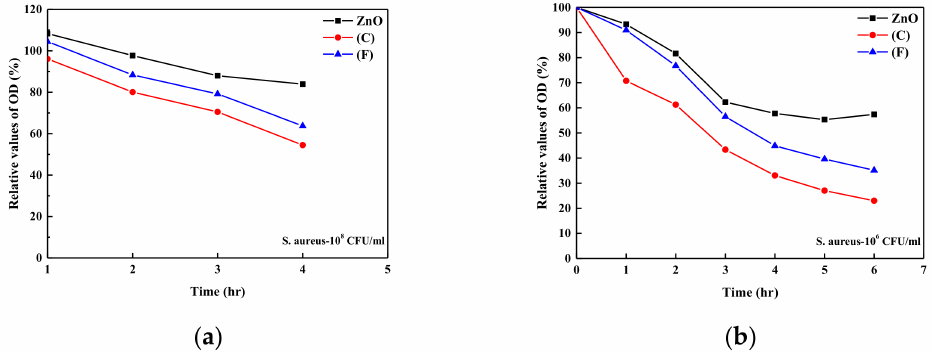
Figure 7. Relative optical density values as a function of time for ( a ) the initial S. aureus concentration of 10 8 CFU / mL and ( b ) 10 6 CFU / mL with pure ZnO sample; samples (C) and (F) in the solutions.